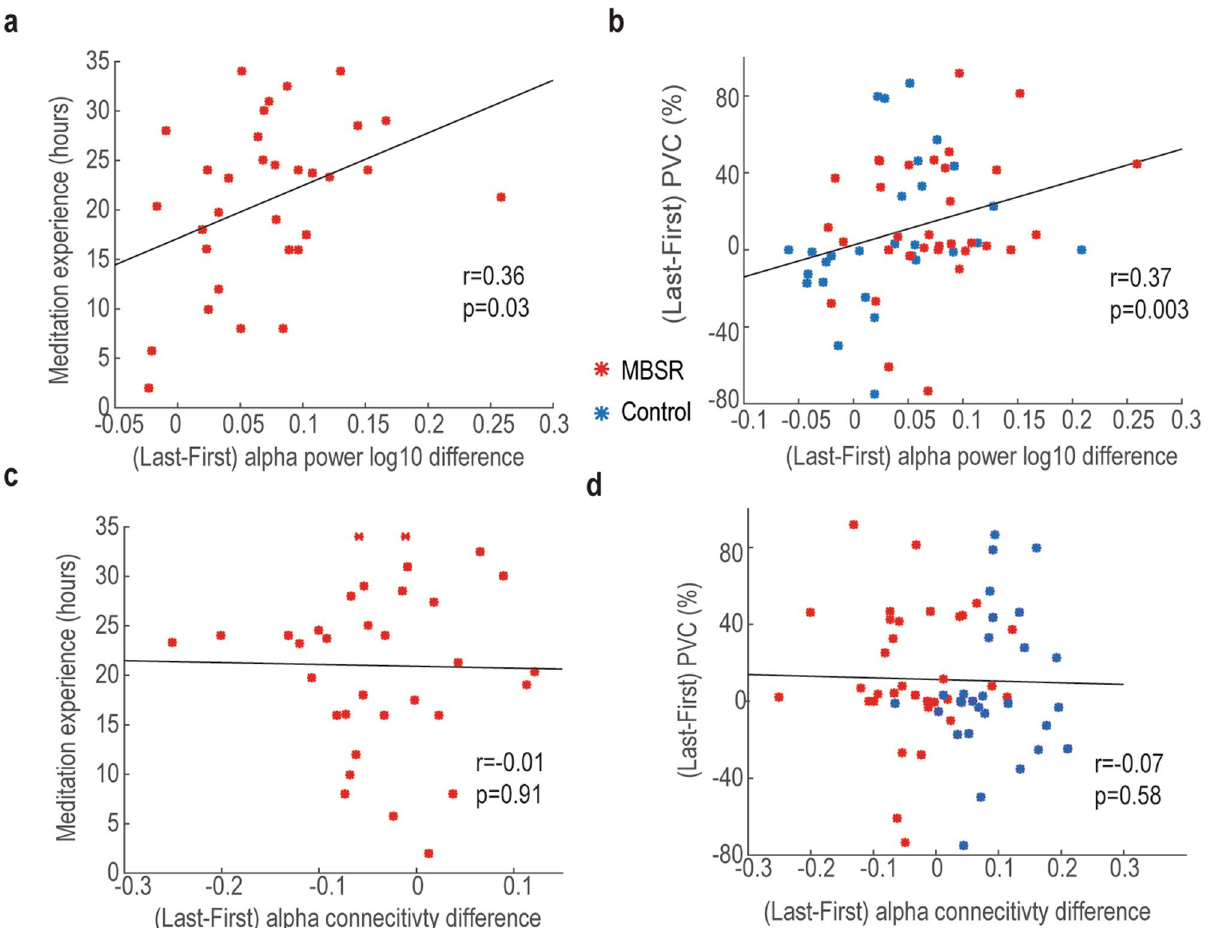
Figure 4. Correlation between neural signals and behavior. ( a ) Correlation between alpha power changes and meditation experience in the MBSR group. ( b ) Correlation between alpha power and PVC changes. ( c ) Similar to ( a ), but correlated with alpha connectivity. ( d ) Similar to ( b ) but correlated with alpha